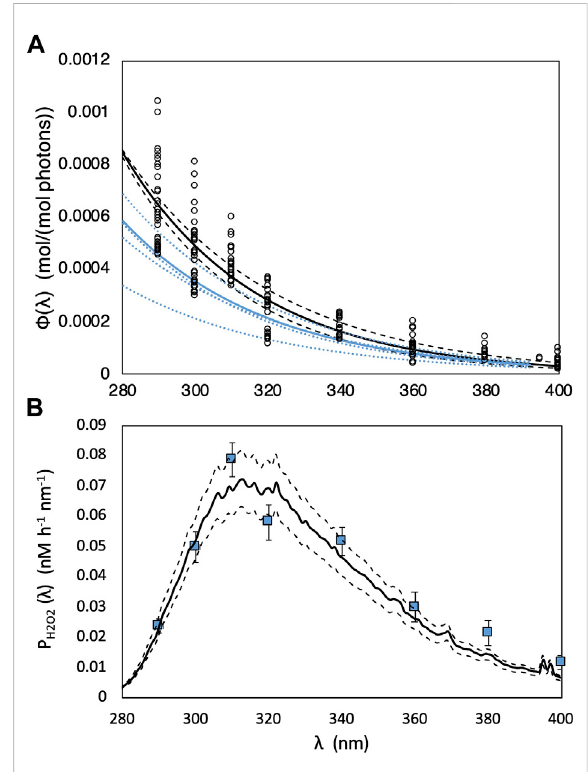
FIGURE 3 (A) “ Marine-average ” AQY spectrum [ Φ ( λ )] versus wavelength ( λ ; nm) (solid black line) computed from all measured monochromatic AQY data at 25 ° C reported in Kieber et al. (2014) (black open dots). Dashed black lines are the modeled AQY spectrum calculated using upper and lower limits of m 1 and m 2 in Table 1. The solid blue line shows pooled Φ ( λ ) computed from polychromaticAQYdata reported inPowersand Miller (2016). Φ ( λ ) from individual experiments reported in Powers and Miller (2016) are depicted with blue dotted lines. (B) Simulated H 2 O 2 ( λ ) ) calculated for the Offshore photoproduction rates ( P H 2 O 2 ( λ ) Station using Eq. 2. The solid black line represents P H 2 O 2 estimated with the “ marine-average ” AQY spectrum, and the blue ( λ ) calculated with average AQY values squares represent P H 2 O 2